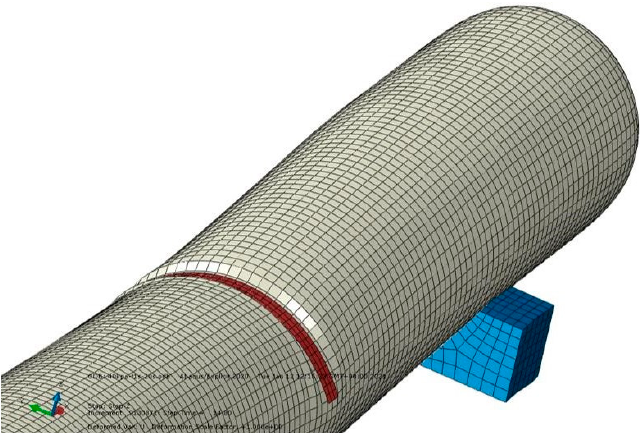
Figure 15. The local wrinkle under ultimate loading.